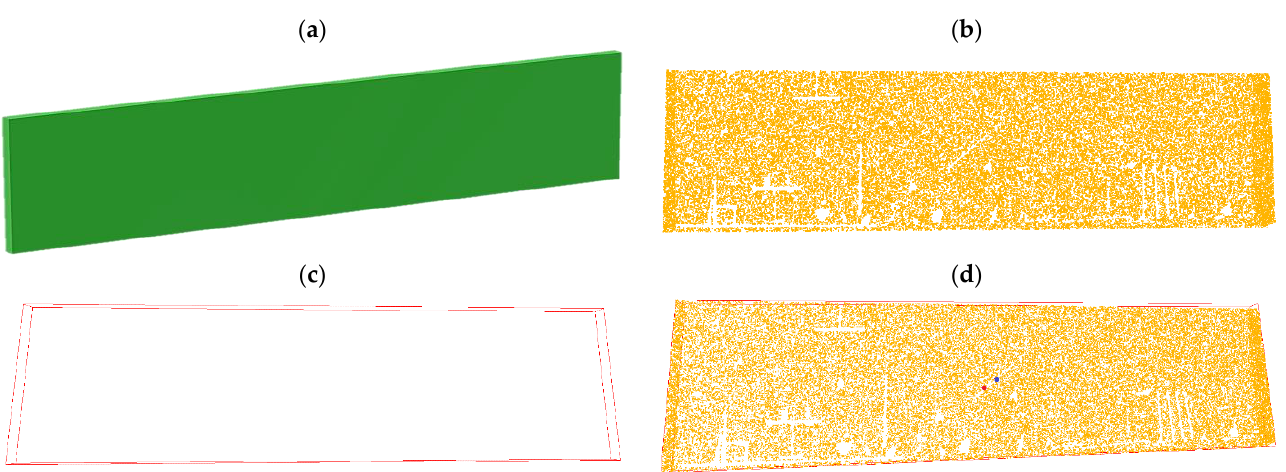
Figure 4. Visualization of ( a ) plane segment from BIM, ( b ) plane segment from original point cloud, ( c ) bounding box of plane segment created from the point cloud, and ( d ) centroid points calculated from the original point cloud (red) and from the bounding box (blue) .